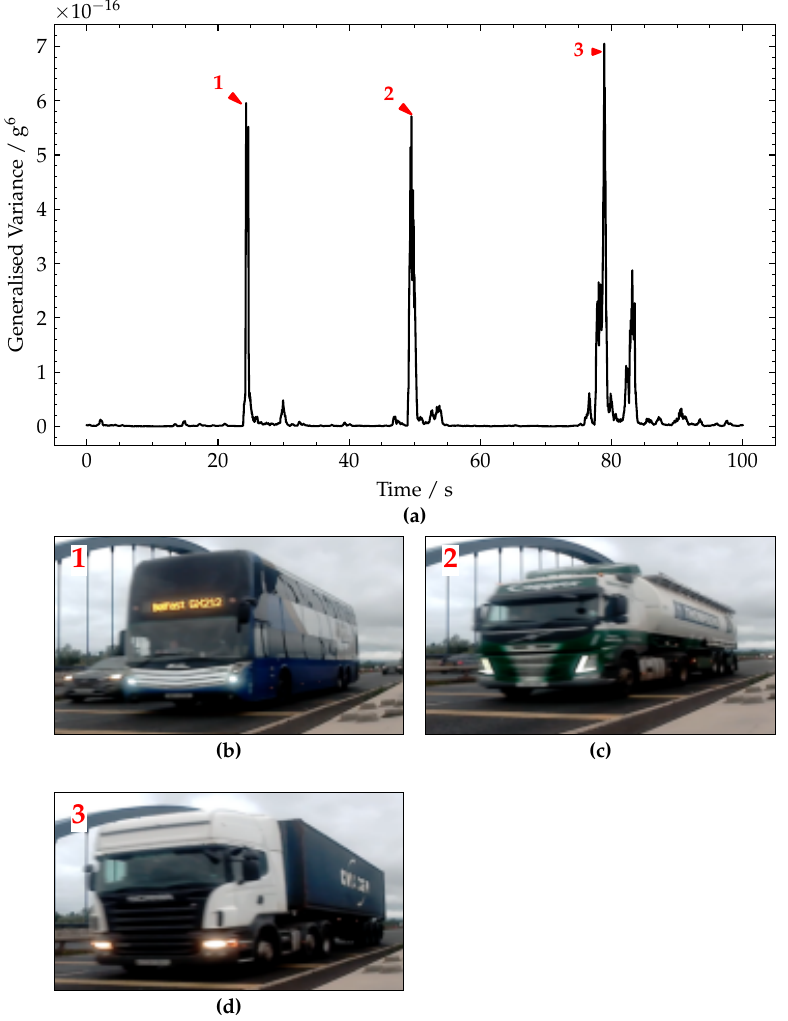
Figure 19. ( a ) Plot of generalised variance signal. ( b – d ) Pictures of vehicles corresponding to peaks annotated 1–3,